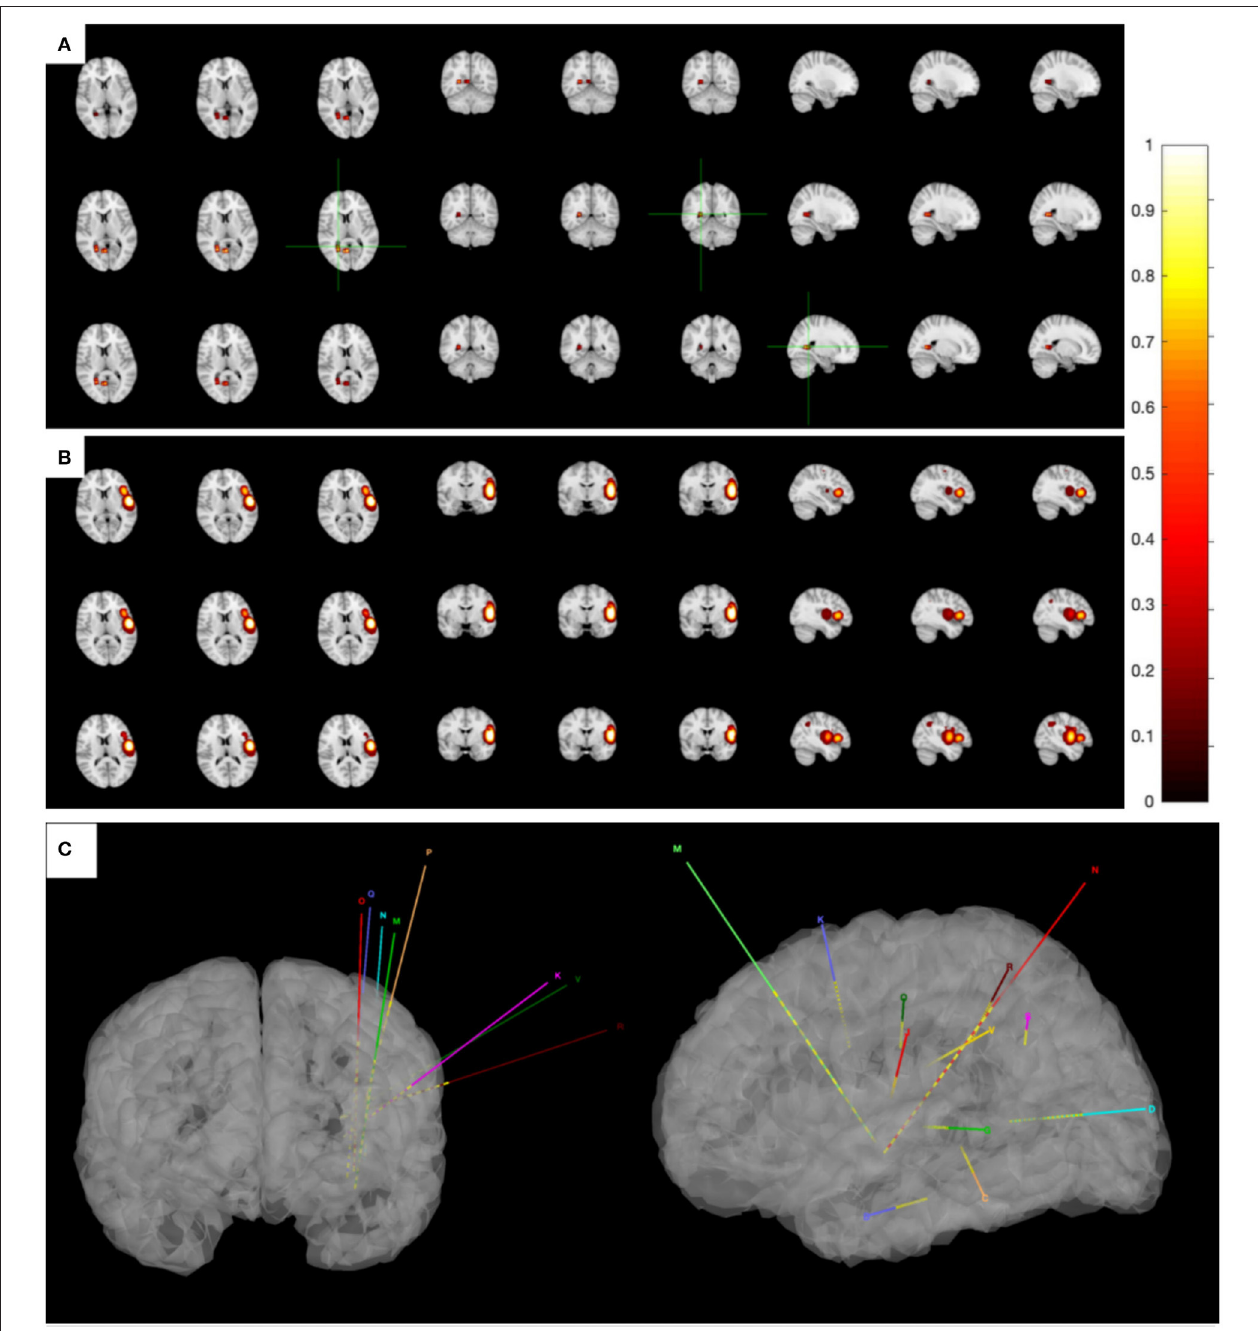
FIGURE 2 | (A) The MEG ECD method delineated epileptic zone at right posterior cingulate cortex. (B) The MEG STOUT method delineated epileptic zone at the left insular long gyrus of island and the parietal opercula. Thirteen spikes were marked in this patient and Source localization was conducted using ECD and STOUT on each spike within a − 100 to 100ms time window around the peak spike signal. All results displayed over the corticalsur face are thresholded at 50% of the maximum amplitude. As ECD method assumes that a small number of focal sources exist that can be equivalent to a few current dipoles in the brain, the result of MEG ECD method is localized to right posterior cingulate cortex. And the STOUT method is localized to the left insular long gyrus of island and the parietal opercula through localization bias compensation. (C) The position of eight intracranial electrodes.